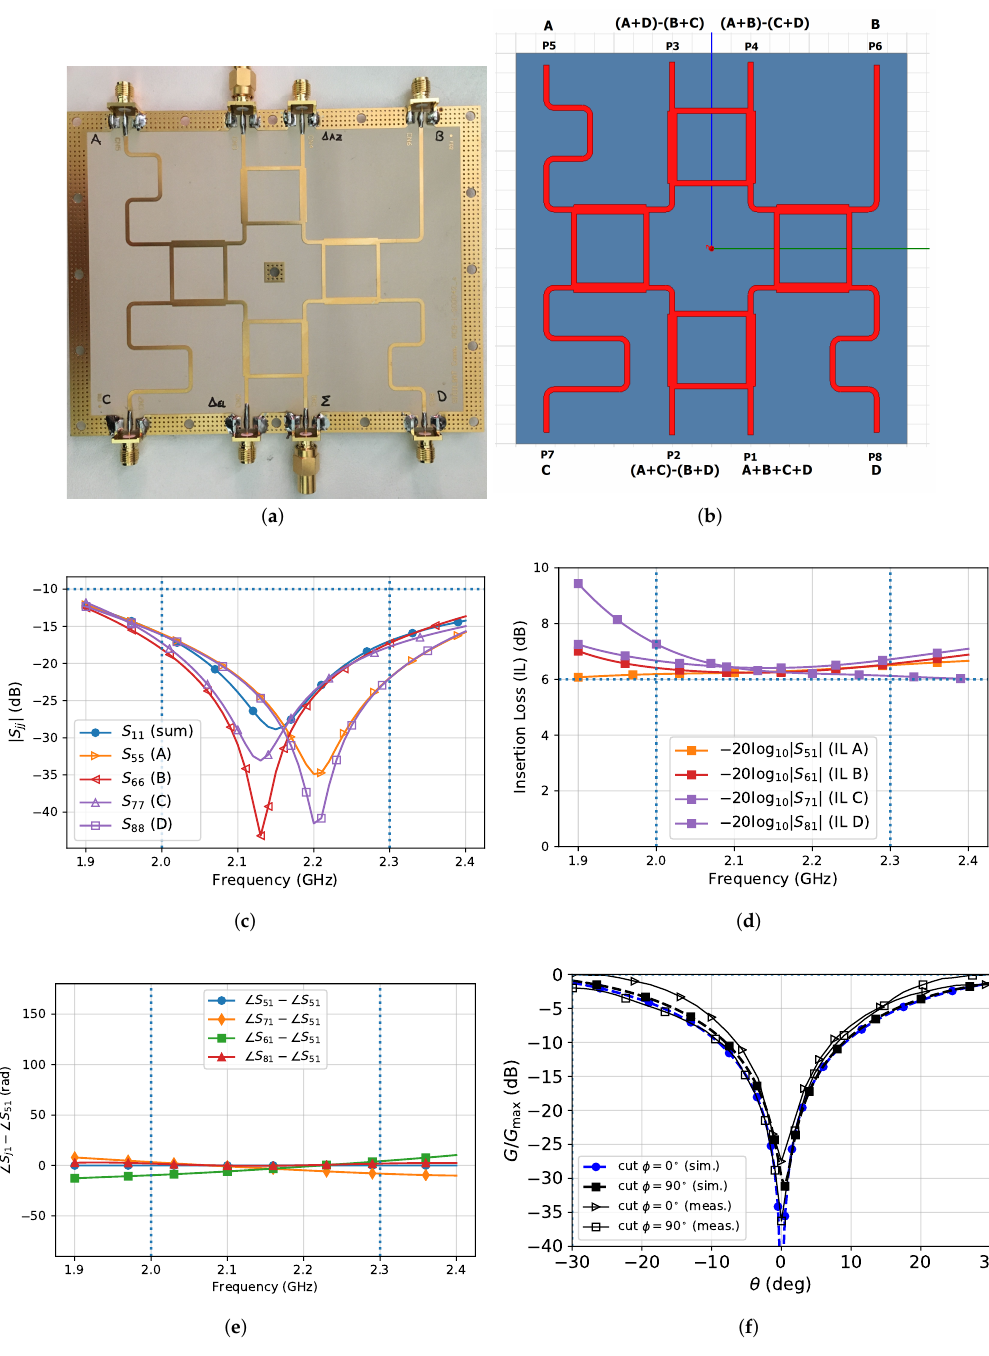
Figure 8. ( a ) Fabricated Σ − ∆ network. ( b ) Layout. ( c ) Reflection coefficient ( S jj ) over all the considered bandwidth ( d ) Insertion Loss. ( e ) Relative phase. ( f ) Comparison of simulated (filled markers) and measured (empty markers) normalized difference patterns required for satellite tracking. Such patterns are obtained by connecting the antenna array to a standard Σ − ∆